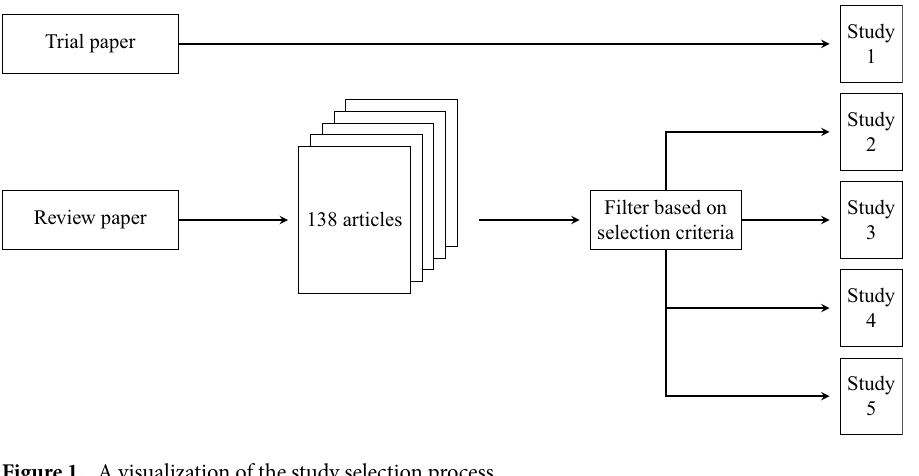
Figure 1. A visualization of the study selection